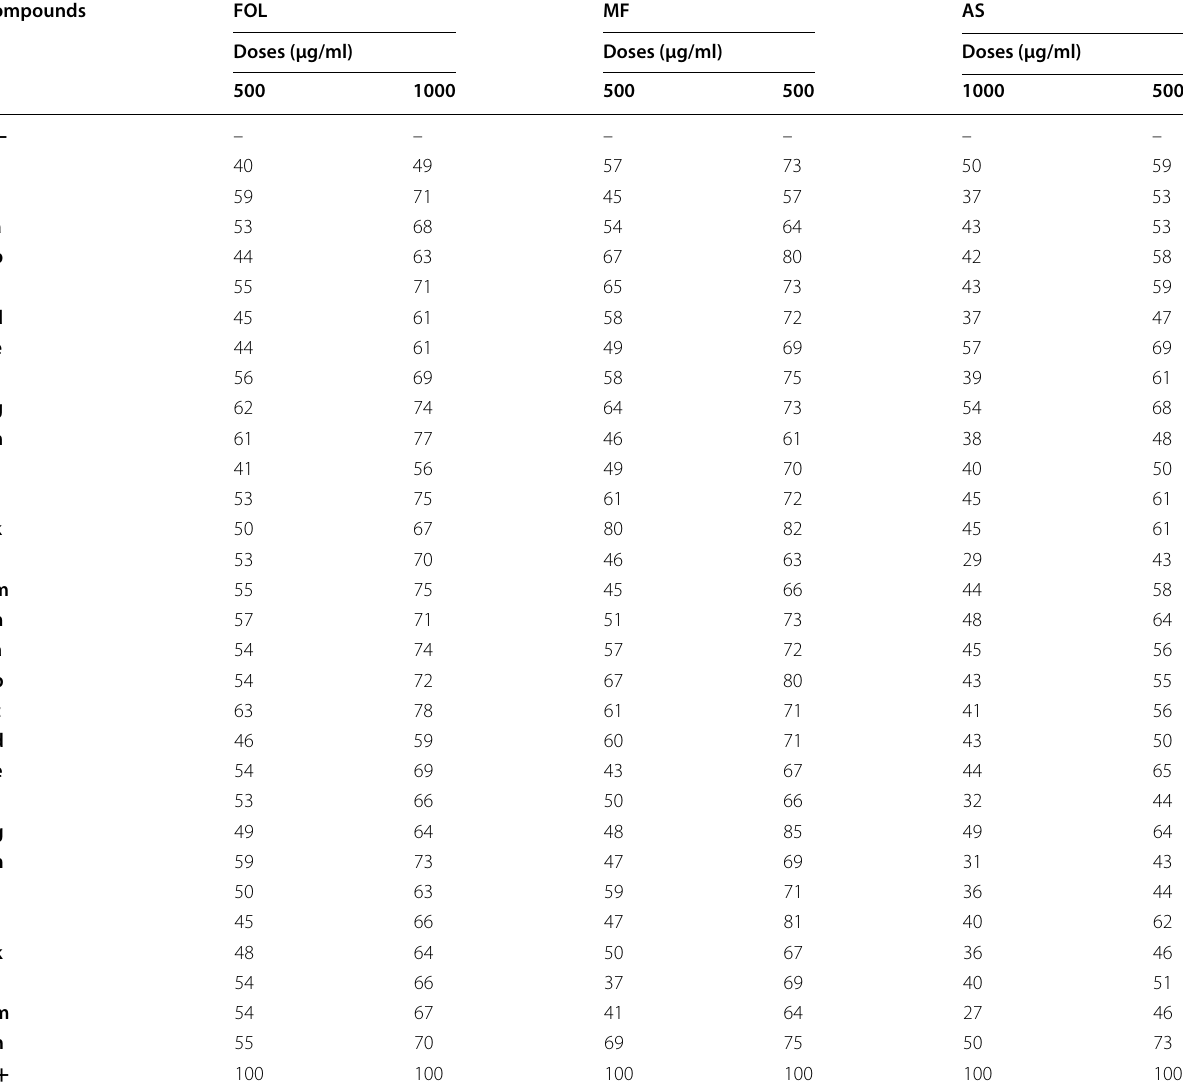
( ), no percentage inhibition; FOL, Fusarium oxysporum f. sp. lycopersici ; MF, Monilia fructigena ; AS, Alternaria solani −